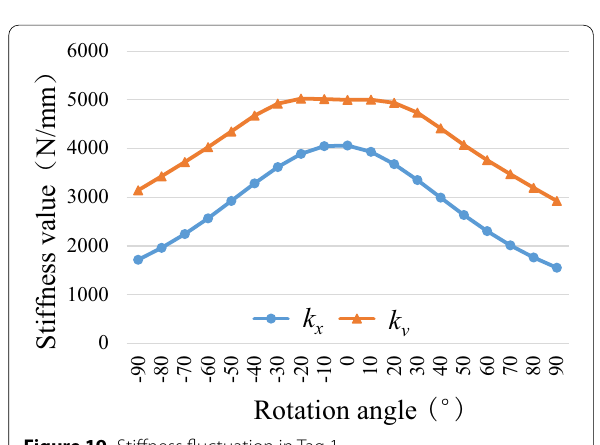
Figure 19 Stiffness fluctuation in Tag